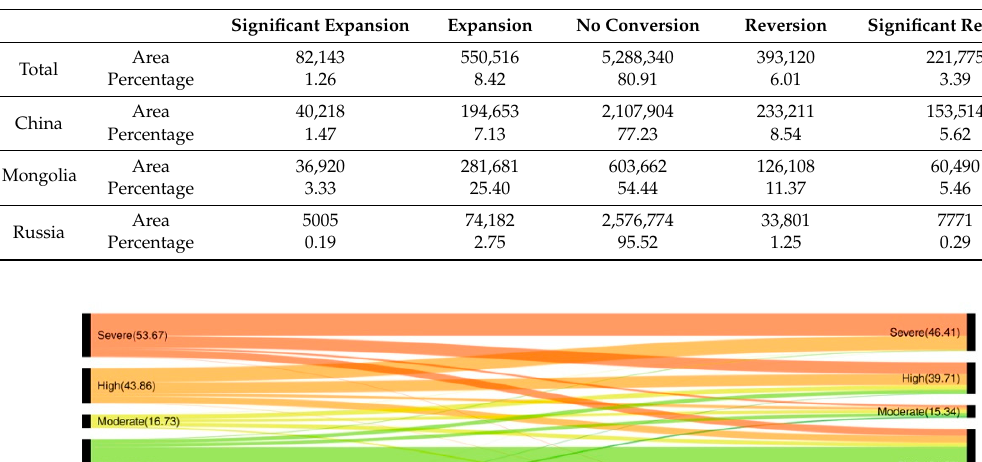
Table 8. The conversions of various desertification degrees from 2000 to 2015 (area: km 2 ; percentage: %).